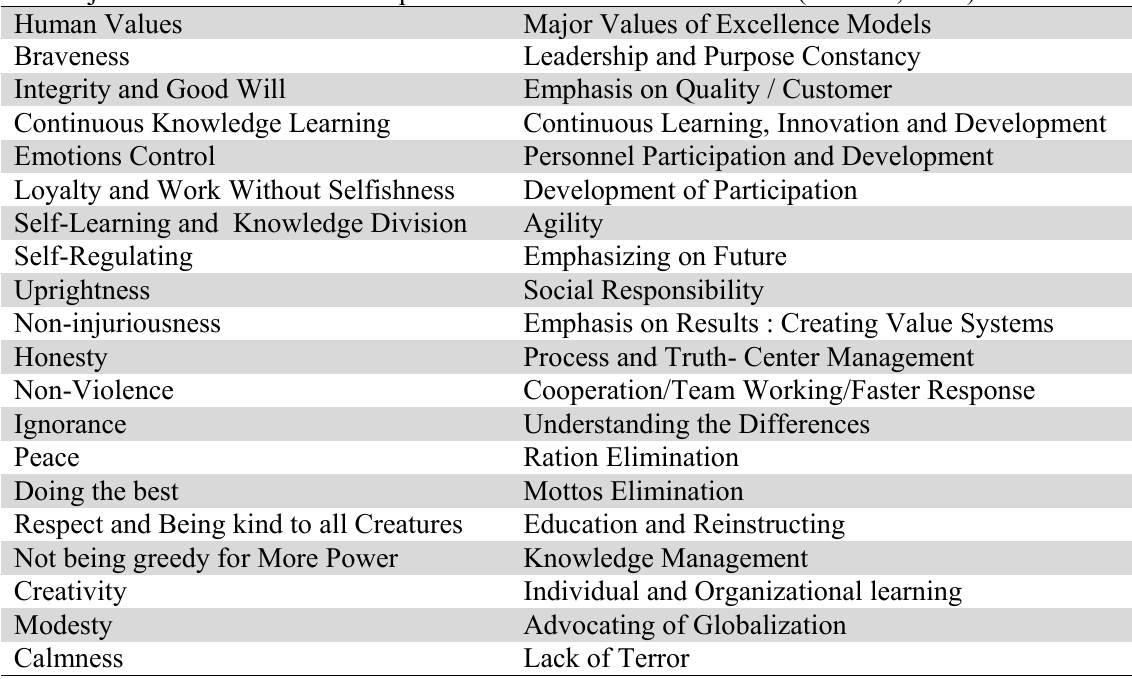
The Major Values/ The First Principles of Sixteen Excellence Models (Trawler,